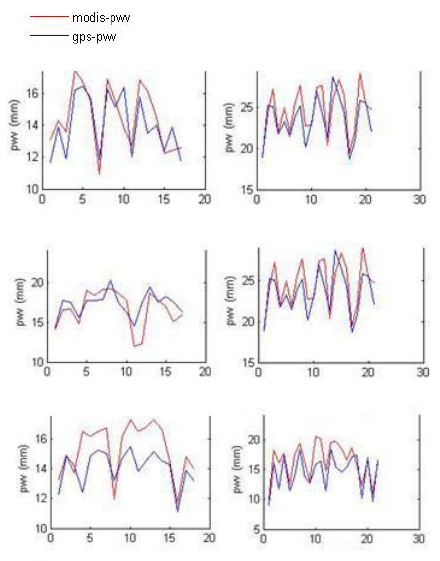
Figure2. comparison of MODIS PWV and GPS PWV of single day for 2015/6/3, 2015/6/7, 2015/6/12, 2015/6/19, 2015/6/20, 2005/10/1